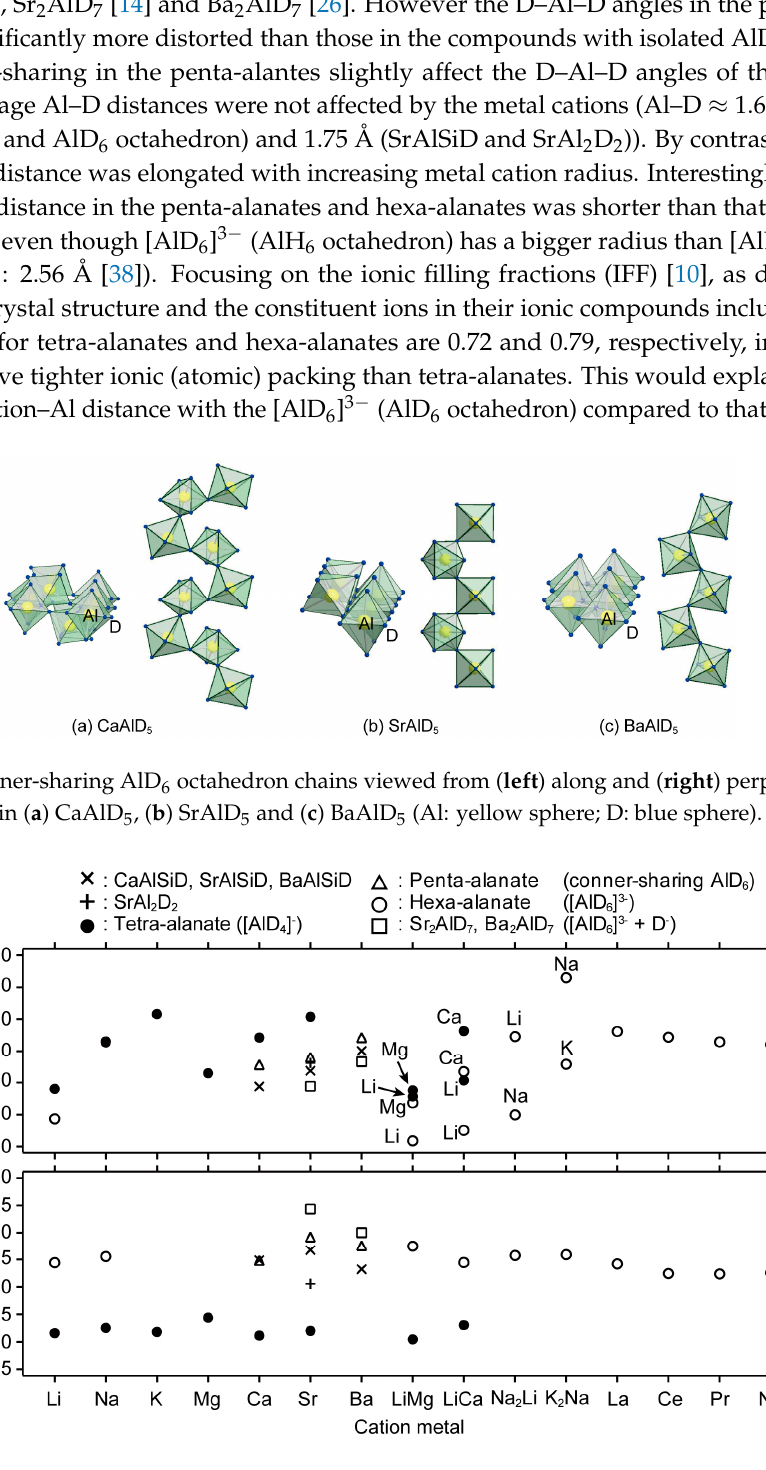
Figure 2. Corner-sharing AlD 6 octahedron chains viewed from ( left ) along and ( right ) perpendicular to the chains in ( a ) CaAlD 5 , ( b ) SrAlD 5 and ( c ) BaAlD 5 (Al: yellow sphere; D: blue sphere).